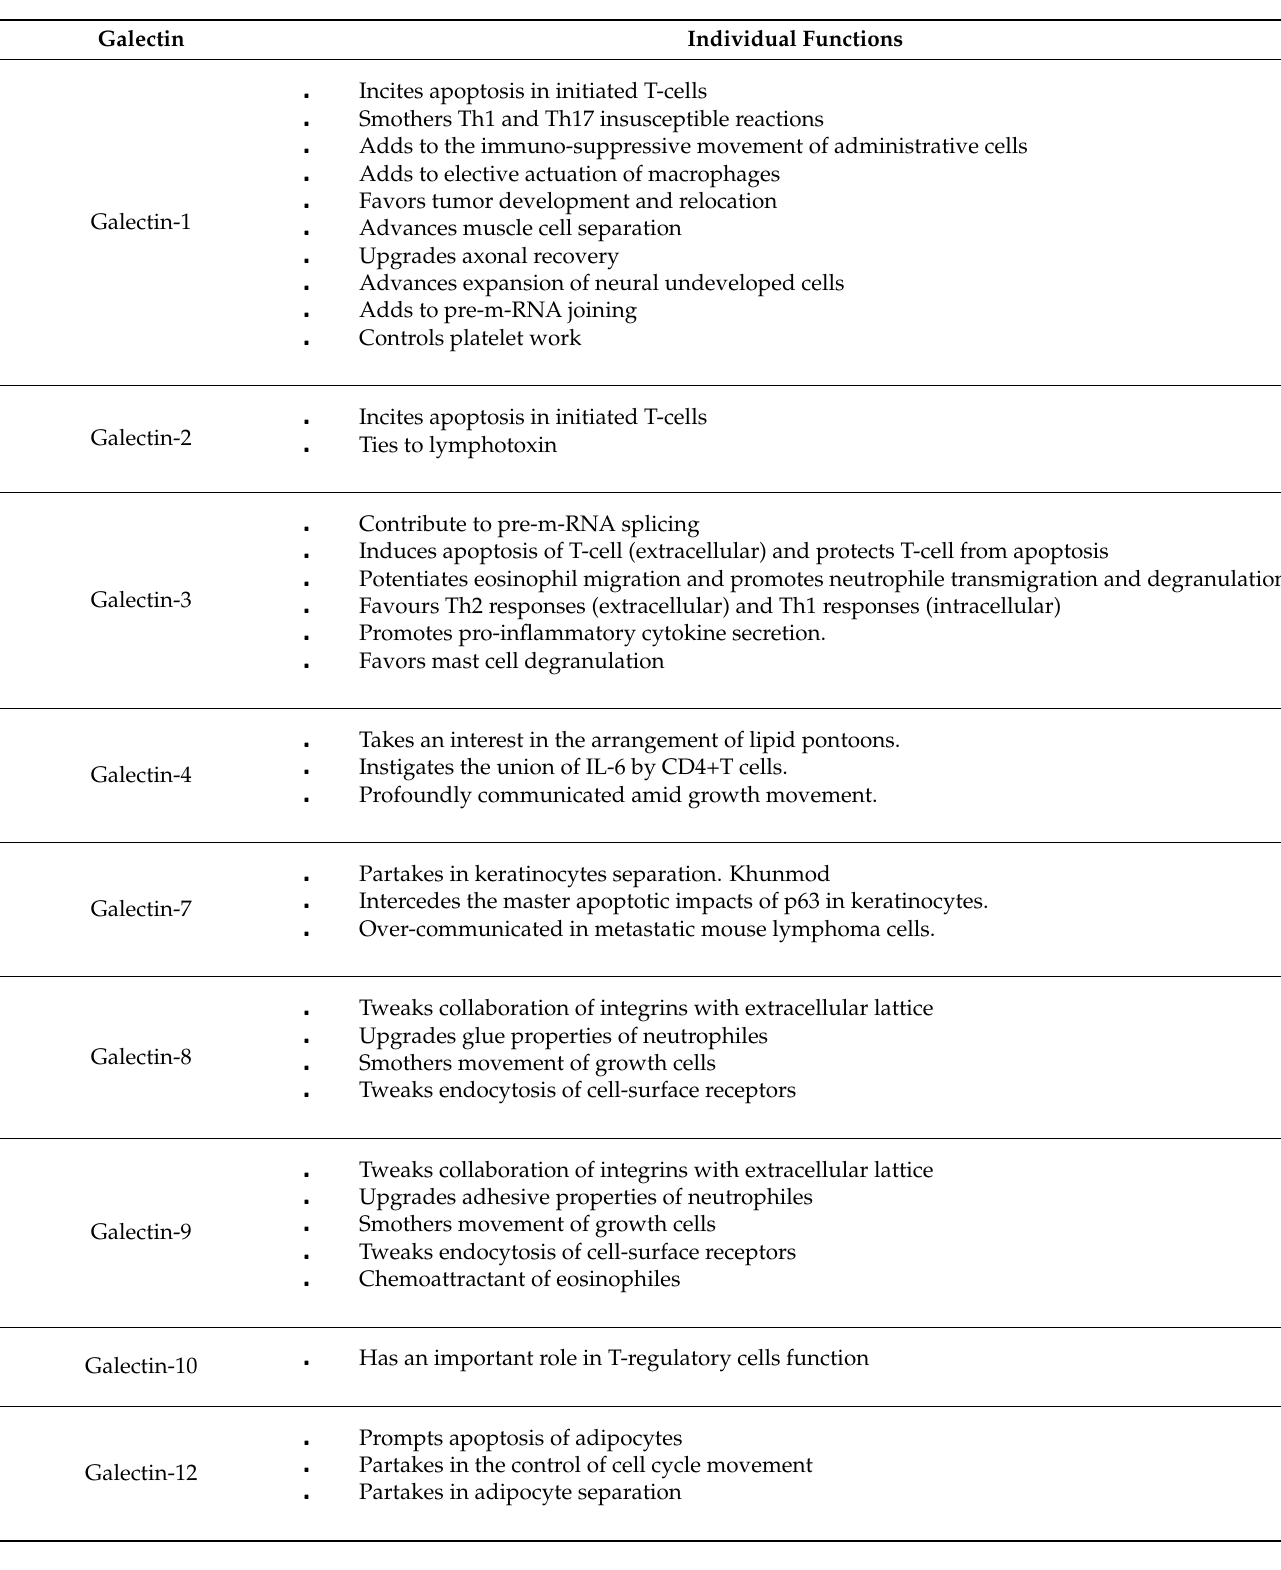
Table 1. Selected biological functions assigned to different members of the galectin